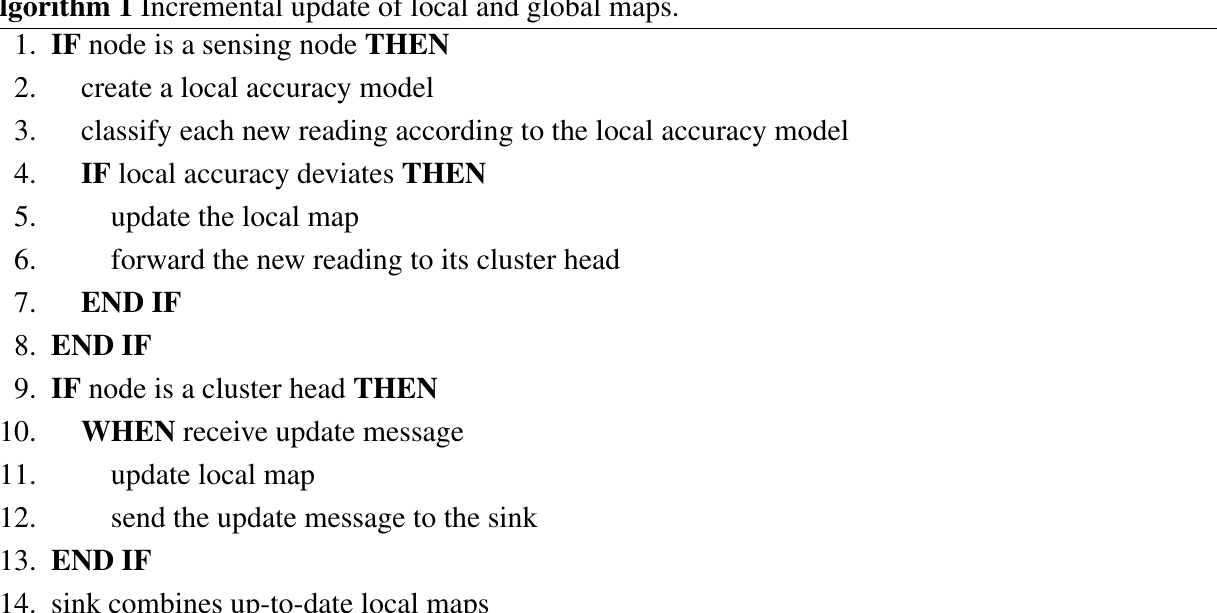
Algorithm 1 Incremental update of local and global